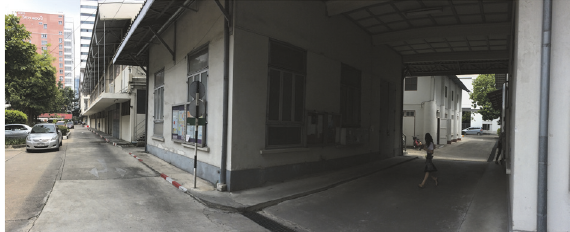
Figure 4: Electrical Engineering Lab.